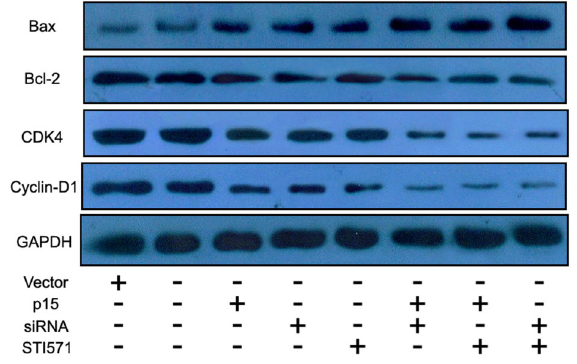
Figure 3. Effect of overexpressed p15INK4B alone or in combination with STI571 and BCR-ABL1 siRNA on cell cycle- and apoptosis-related proteins in K562 cells. K562 cells were transiently transfected with p15INK4B, BCR-ABL1 siRNA or p15INK4B++BCR-ABL1 siRNA. After 24 h, the cells were plated onto 6-well plates at a density of 1 6 10 6 cells/well and incubated for another 24 h. Then, the cells were treated with STI571 (5 m mol/L) for 24 h and Western blot was